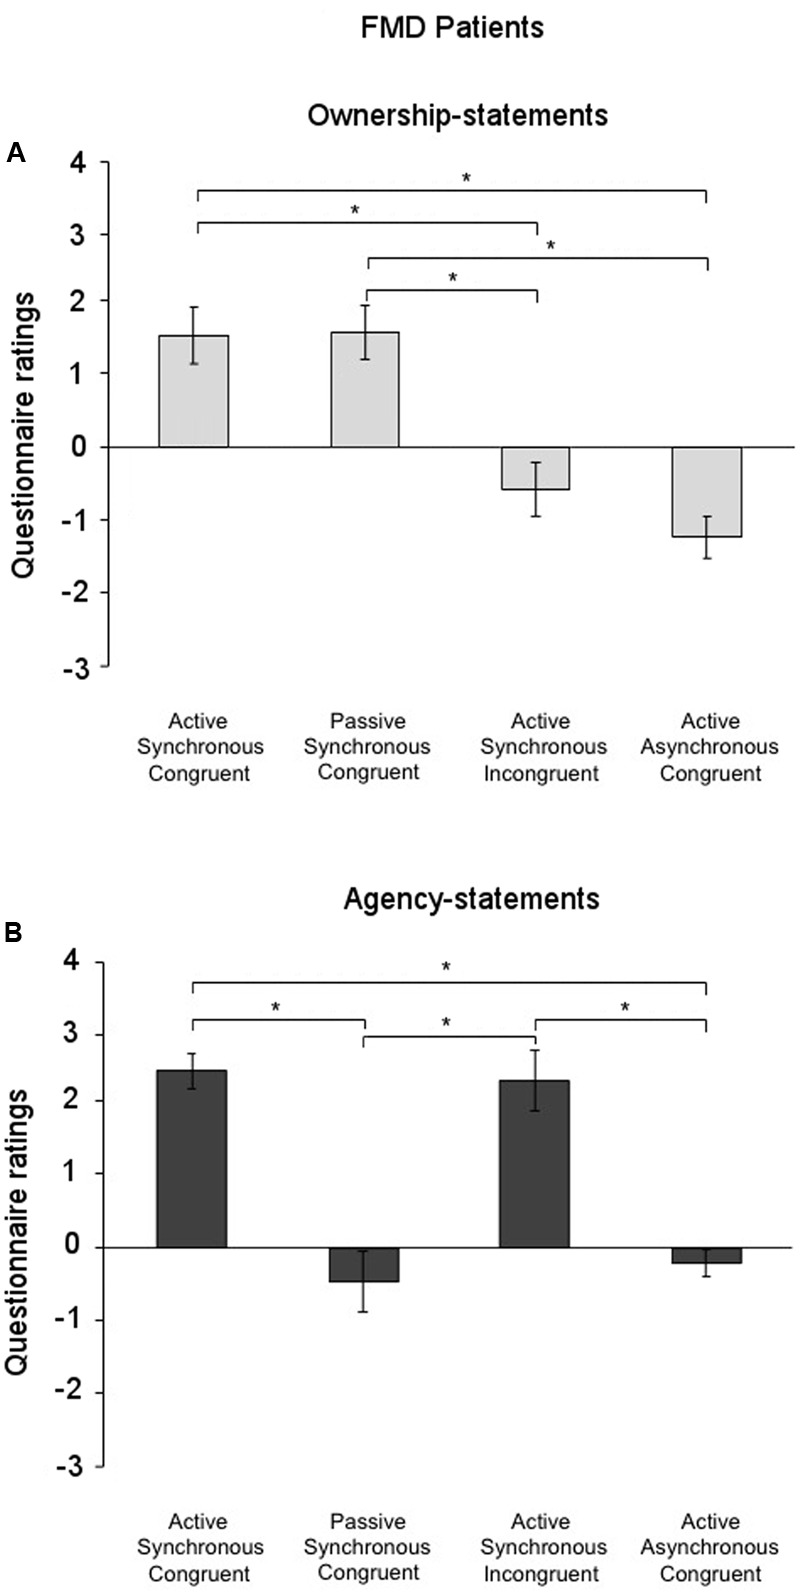
Ownership and agency across conditions in the functional movement disorders group. (A) Mean scores for the ownership-statements and (B) the agency-statements across conditions in the functional movement disorders group. Gray lines and asterisks show significant comparisons across conditions. The results showed that agency and ownership were differently elicited by each condition. Error bars indicate standard errors.